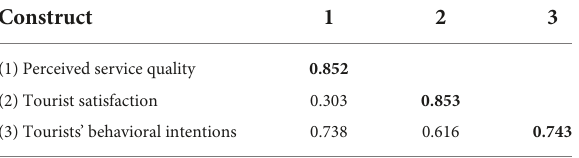
TABLE 6 Discriminant validity based on Fornell–Larcker